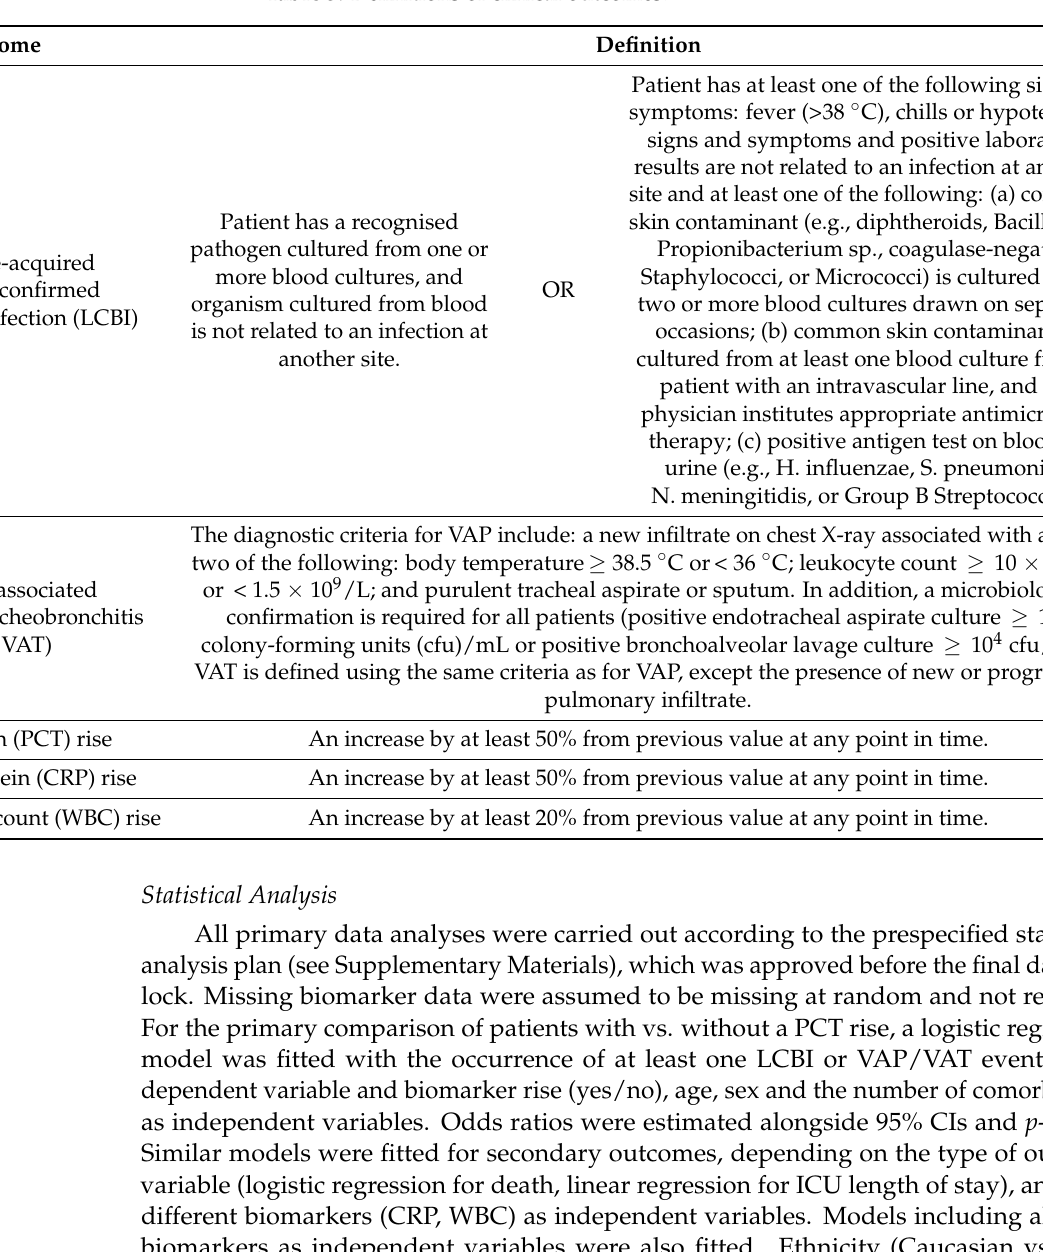
Table 3. Definitions of clinical